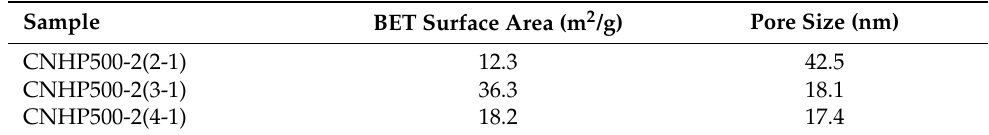
Figure 2. Nitrogen adsorption-desorption isotherms and their corresponding pore size distribution curves (inset) for sample ( a ) CNHP500-2(4-1), ( b ) CNHP500-2(3-1), and ( c ) CNHP500-2(2-1). Table 1. Textural properties of the